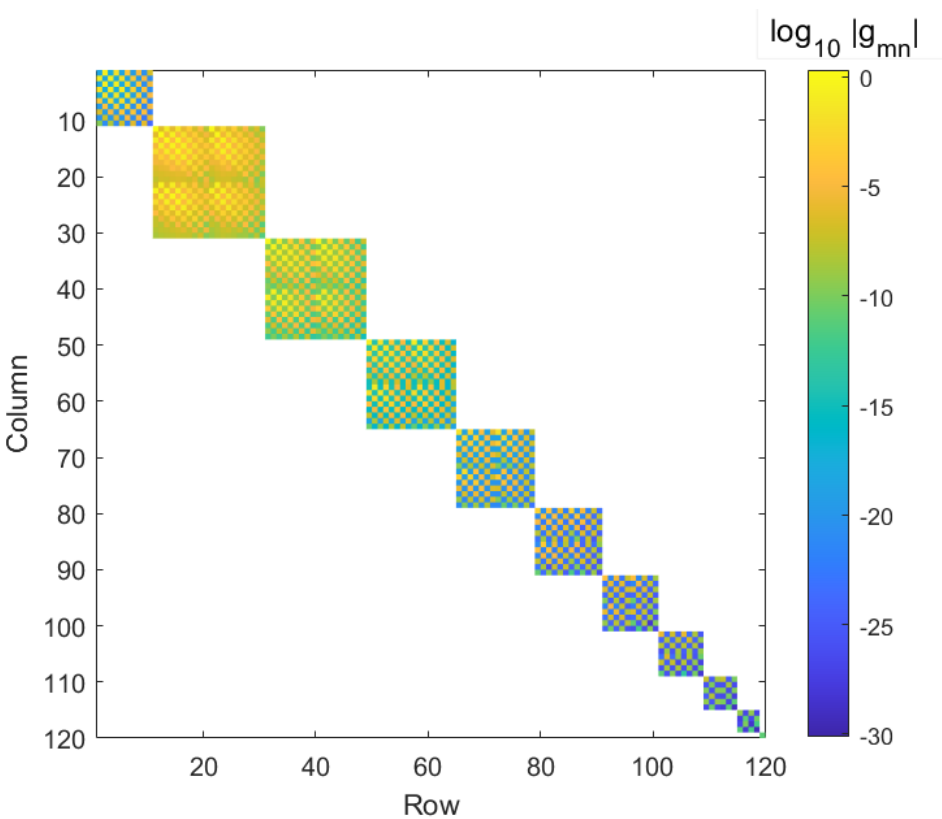
Figure 6. Amplitude of the elements of the 120 × 120 matrix G for the case with θ = 60 ◦ , ka = 5.5, kb = 2.29, c = 5, ξ 0 = 1.1, d = 10, m t = 10. All elements with zero value are represented in white.